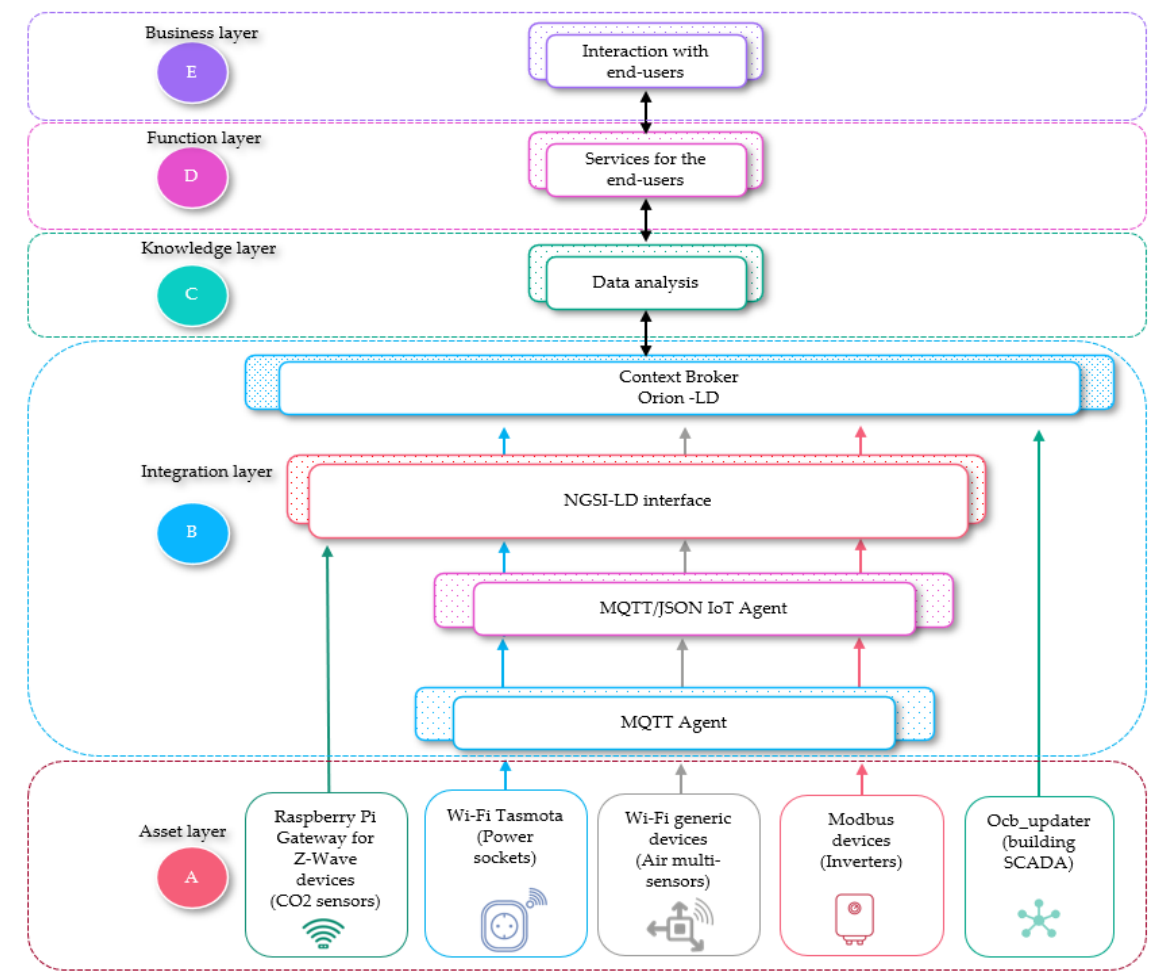
Figure 3. Asset layer of PoC pilot site.